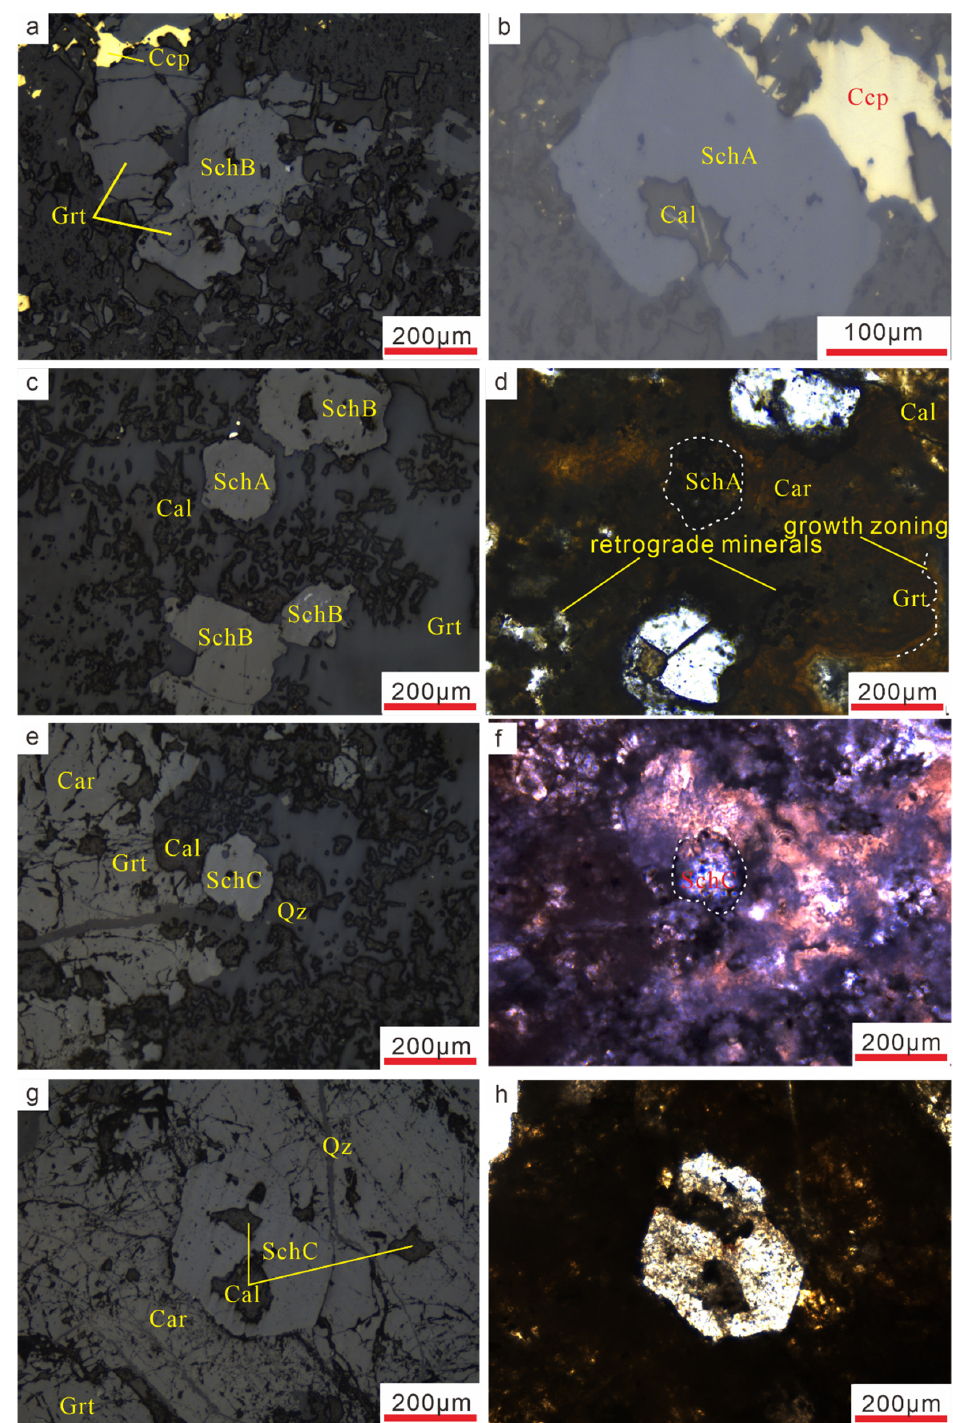
Figure 4. ( a , b ): Subhedral scheelite grain occurring in ZK2002 (SchA and SchB); ( c , d ): Subhedral- anhedral scheelites observed in ZK2002 (SchA and SchB), ( d ) is the crossed polars transmitted light images of image “c”; ( e – h ): Subhedral to anhedral scheelite occurring in ZKB20S, which are mostly associated with calcite and quartz stockwork (SchC). Abbreviations: Sch—scheelite, Grt—garnet, Ccp—chalcopyrite, Cal—calcite, Car—carbonates, Qz—quartz.